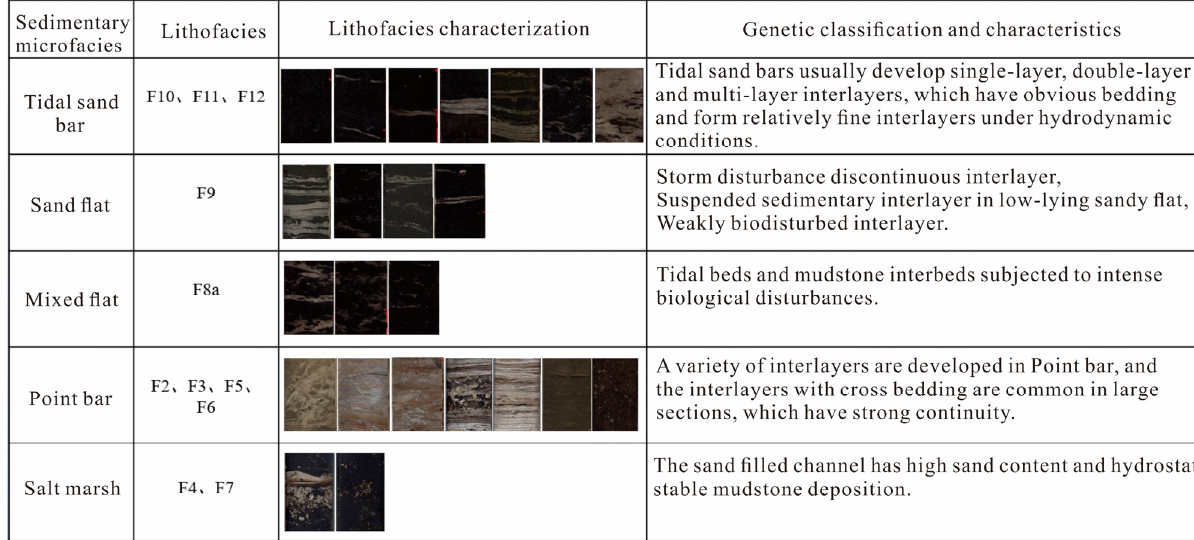
Figure 5. Types of lithofacies and corresponding sedimentary microfacies.